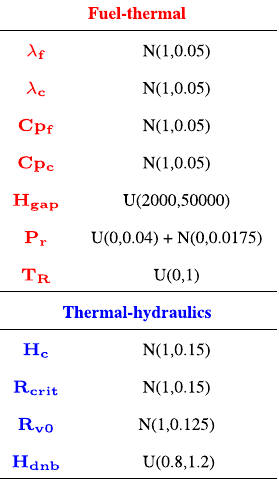
Fig. A.1. Input uncertainty quantification, where U(a,b) is a uniform distribution over (a,b) and N(a,b) is a normal distribution with mean a and standard deviation b. P r is the sum of two independent random